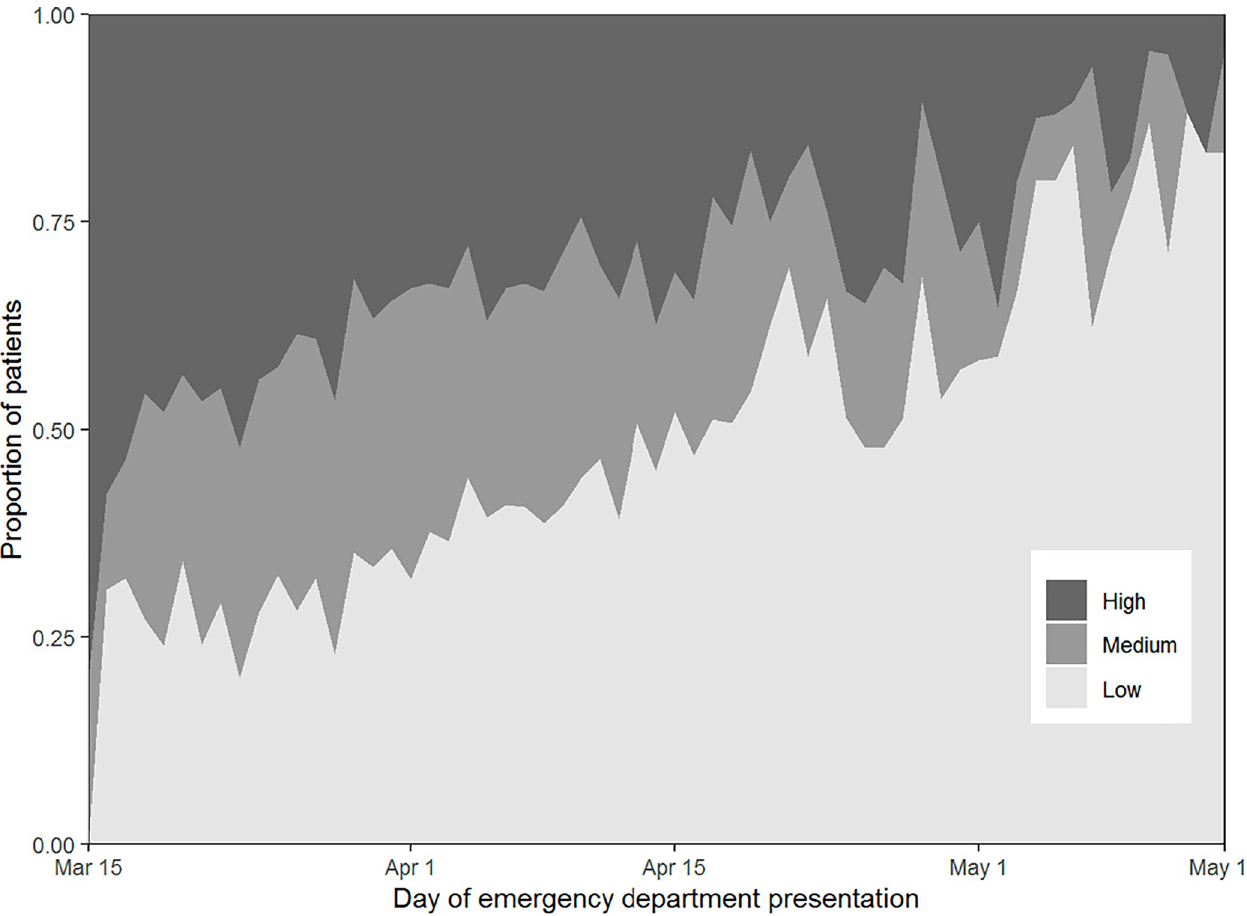
Fig 2. Proportions of patients presenting to the emergency department with high, medium, and low SARS-CoV-2 viral loads over time. study (Figs 4 and 5: blue lines vs. red lines). This model predicts that if viral load had stayed constant and not declined, there would have been 69 additional deaths (95% CI: 50–90) throughout the study period, or a 5.8% greater number of deaths (95% CI: 4.2–7.6%).